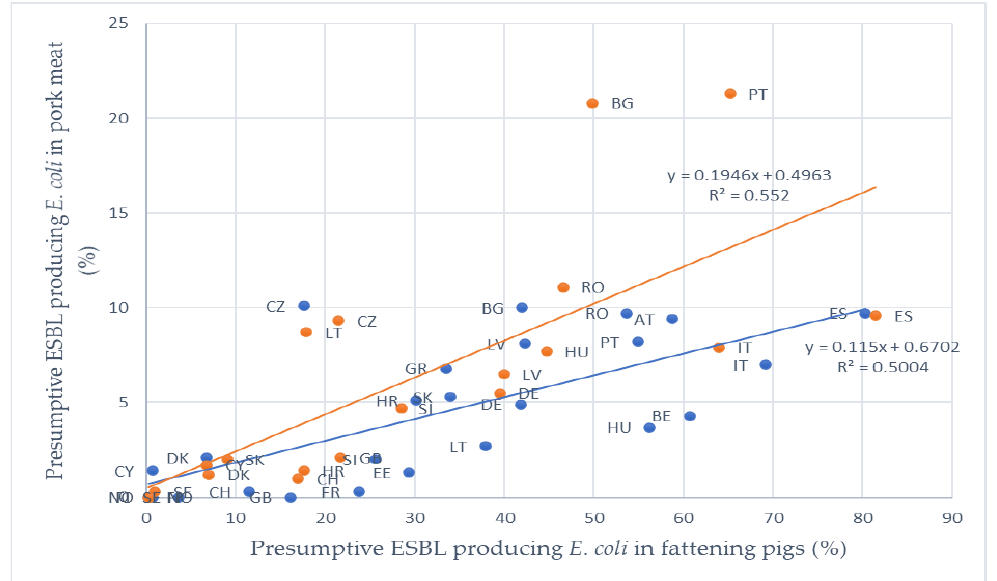
Figure 3. Correlation between the prevalence of presumptive ESBL producing E. coli in pork meat and in fattening pigs in 2015 (orange color) and 2017 (blue color). Country codes used according to ISO 3166.